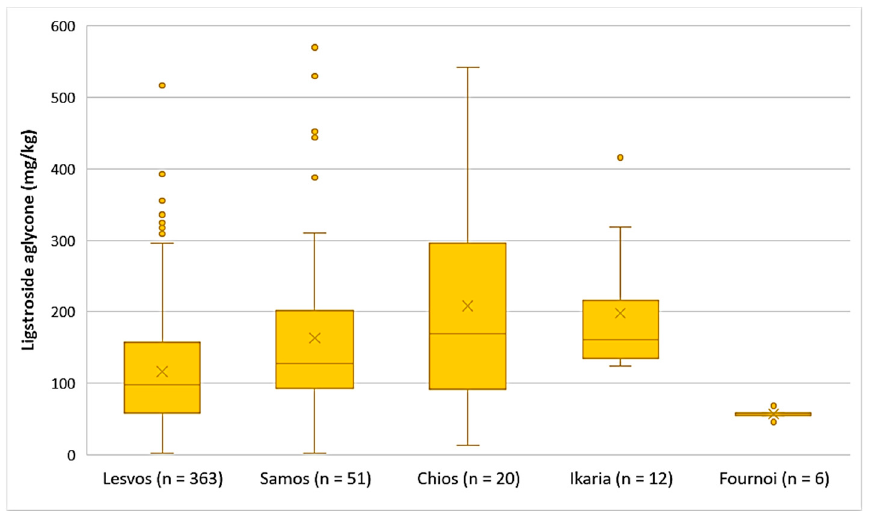
Figure 5. Concentration of ligstroside aglycone (mg/kg) in EVOOs from the islands of Lesvos, Samos, Chios, Ikaria, and Fournoi.